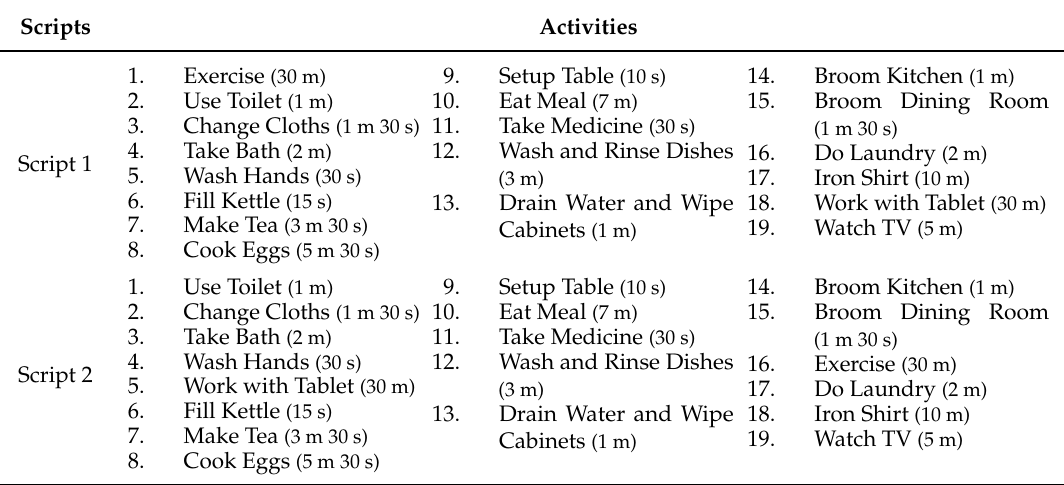
Table 2. Scripted sequence of activities of daily living performed by participants in [8] followed by their estimated time of